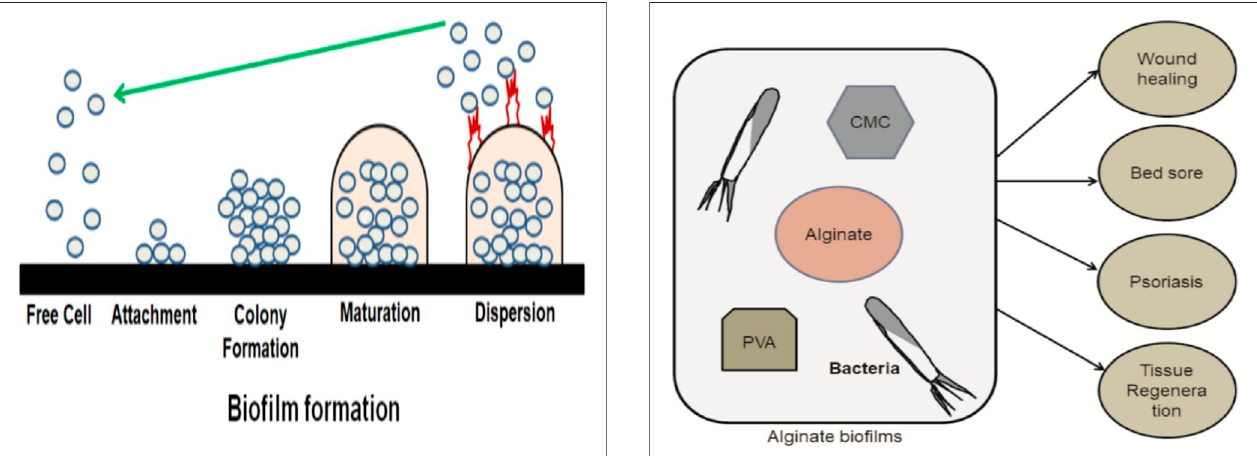
FIGURE4| ThesimplestepsofAlginatebio fi lmspreparation(CMC-and PVA-based) with the target group and their proposed application in a fi eld of